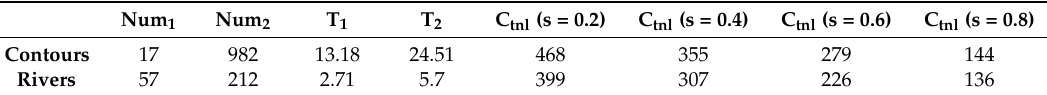
Table 3. Data sizes, running times and the series of C tnl (in meters), (Num 1 : number of records; Num 2 : number of characteristic points; T 1 : time to extract the critical points in seconds; T 2 : time to determine the optimum correspondence in seconds).